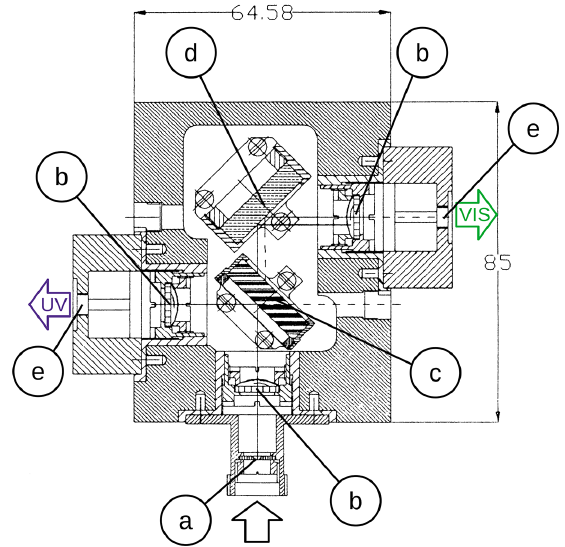
Figure 3. Schematic of the receiving block: (a) field stop diaphragm (0.8mm diameter), (b) collimation lenses ( f = 20mm), (c) dichroic beam splitter ( λ = 440nm), (d) 45 ◦ mirror, and (e) optical fibre con- nector. Dichroic beam splitter and UV collimation lens are currently not present in the receiving block of the 15cm telescope.